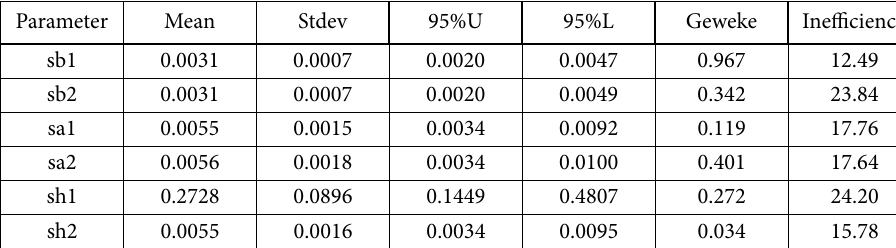
Table 5. Estimation results of the TVP-VAR model (source: authors’ calculation)